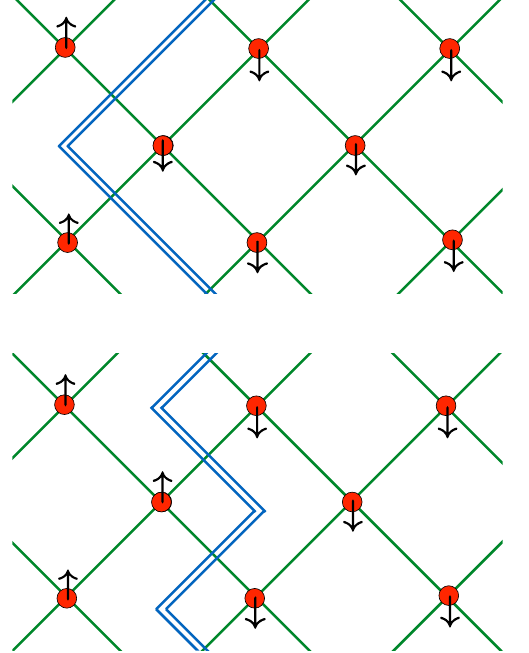
FIG. 16. A section of one of the domain walls in the bulk (double line). The two configurations shown have equal